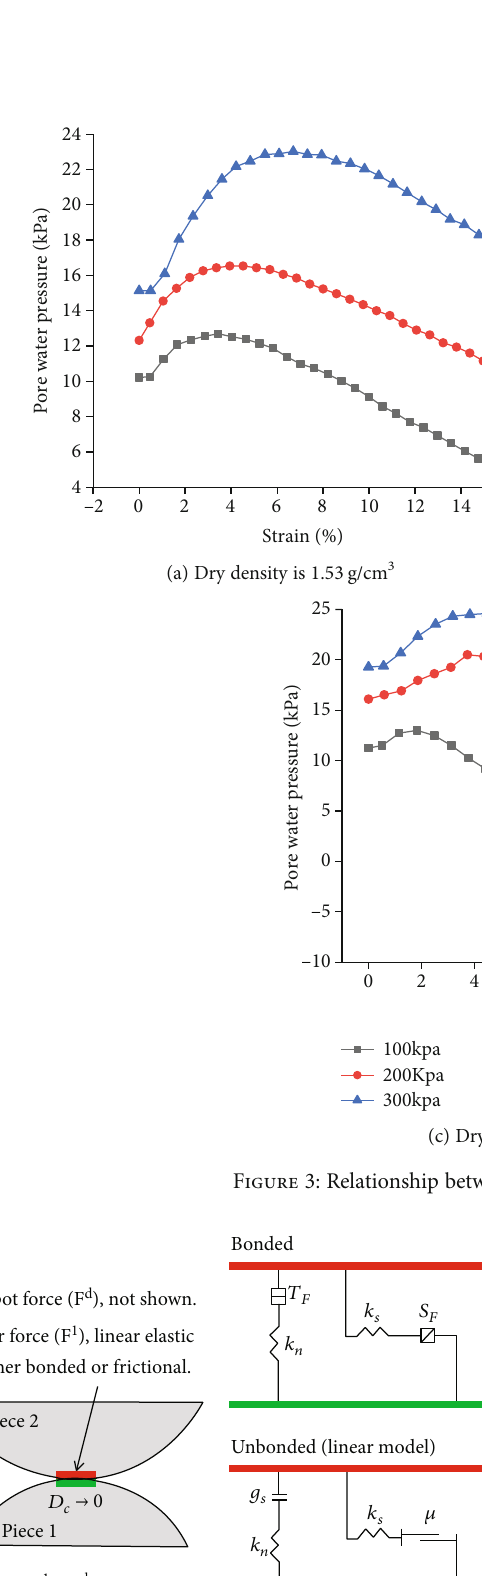
c is contact is normal n